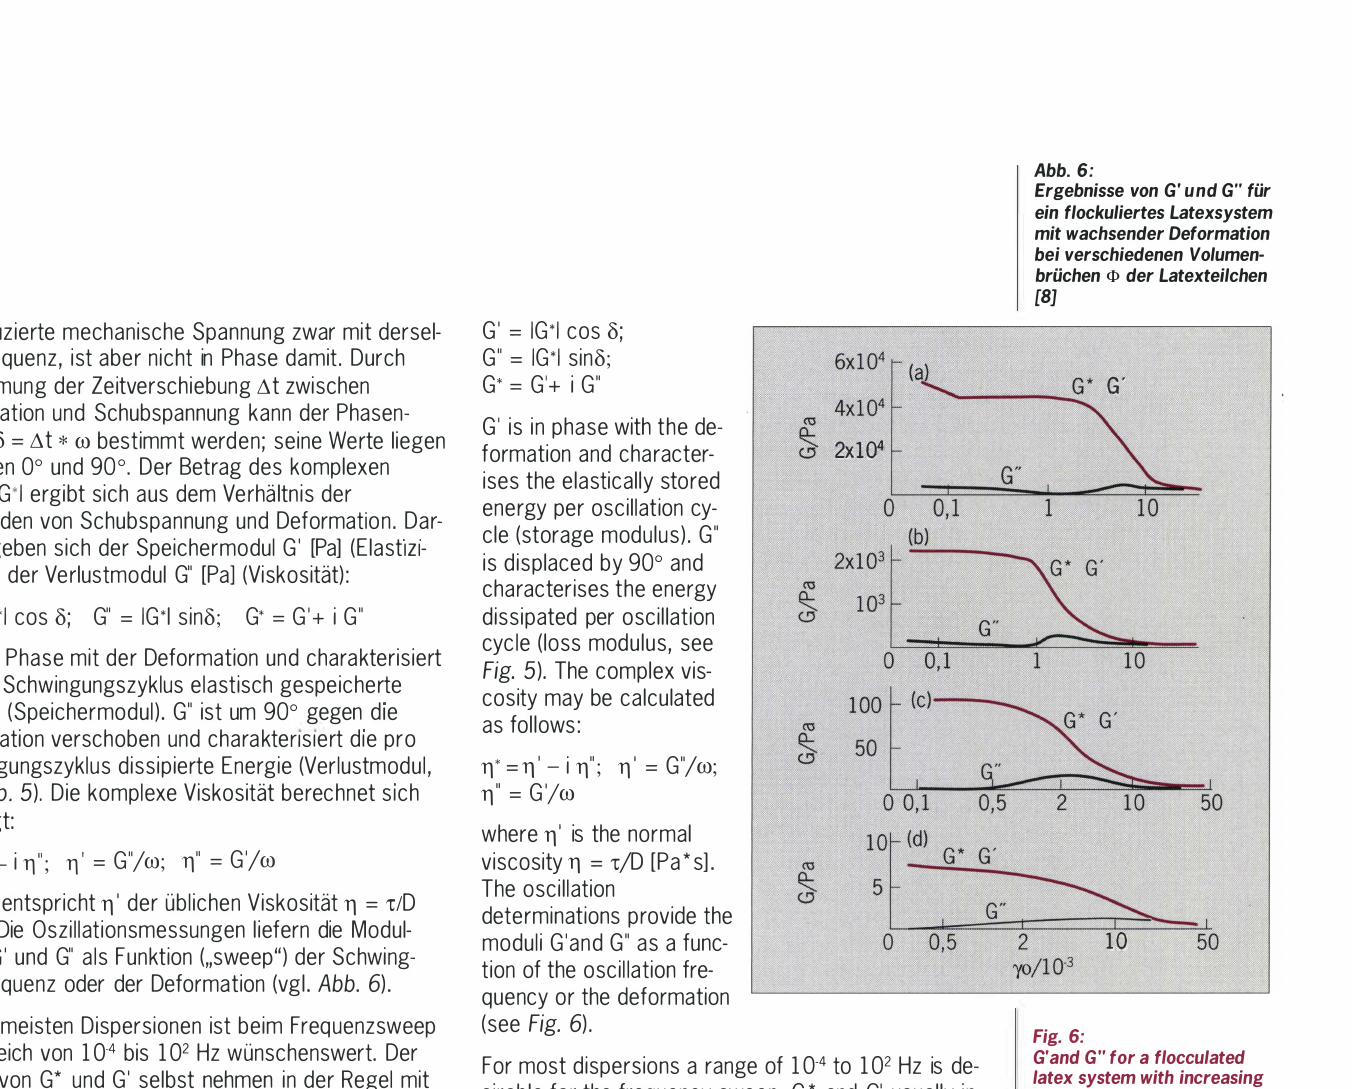
')'0/10•3 Fig. 6: G'and G" for a flocculated latex system with increasing deformation at different volume fractions of the latex particles <1>